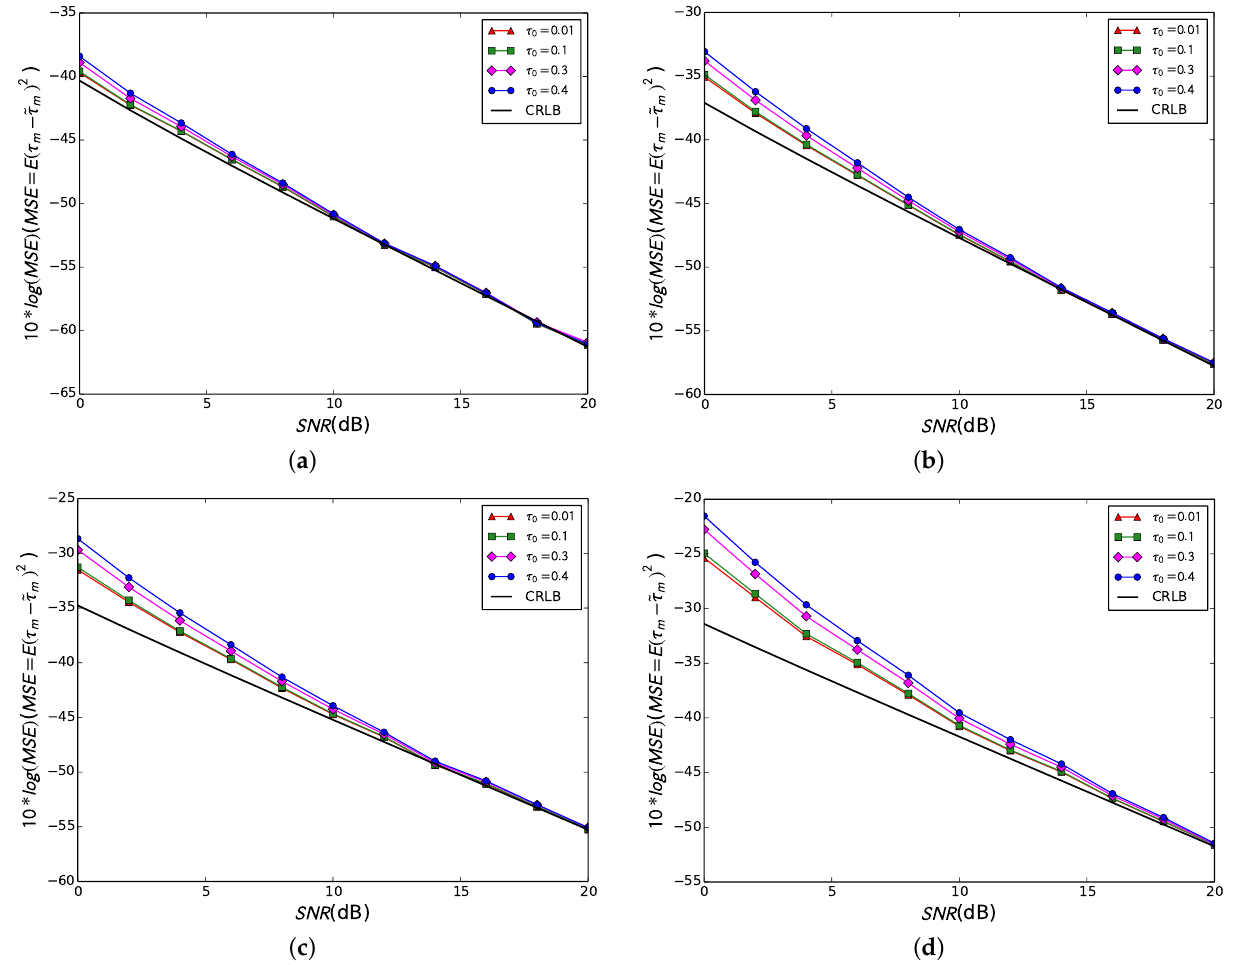
Figure 5. Performance evaluations with various bandwidths and time delays. ( a ) BT = 1/2, N = 16,384, P = 11, θ = 1; ( b ) BT = 1/3, N = 16,384, P = 11, θ = 1; ( c ) BT = 1/4, N = 16,384, P = 11, θ = 1;